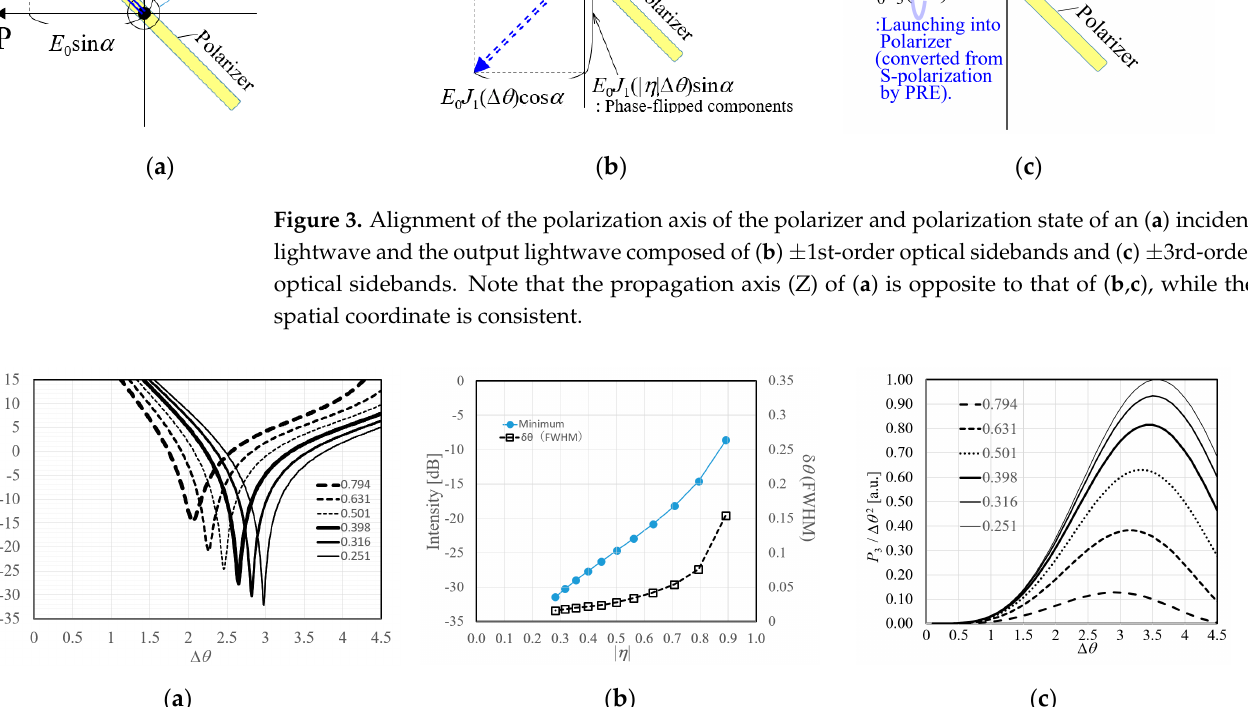
Figure 4. ( a ) Dependence of 1st-order optical sideband intensity on ∆ θ when η is in negative and its absolute value | η | equals to 0.794 (2 dB attenuation), 0.631 (4 dB attenuation), 0.501 (6 dB attenuation), 0.398 (8 dB attenuation), 0.316 (10 dB attenuation), 0.251 (12 dB attenuation). Polarization extinction ratio ξ is assumed to be 10 4 . All plots are normalized by the intensity of ± 3rd-order optical sidebands obtained from each η . ( b ) Minimum intensity and 3-dB width of the dips in ( a ) versus | η |, ranging from 1 dB to 11 dB with a step of 1 dB in RF attenuation 1/| η |. ( c ) Output power of desired wavelength component P 3 normalized by ∆ θ 2 being proportional to input RF power. Calculation is performed using Equation (10) and setting of | η | is common with ( a ). All traces are normalized by the maximum when | η | equals to 0.251.